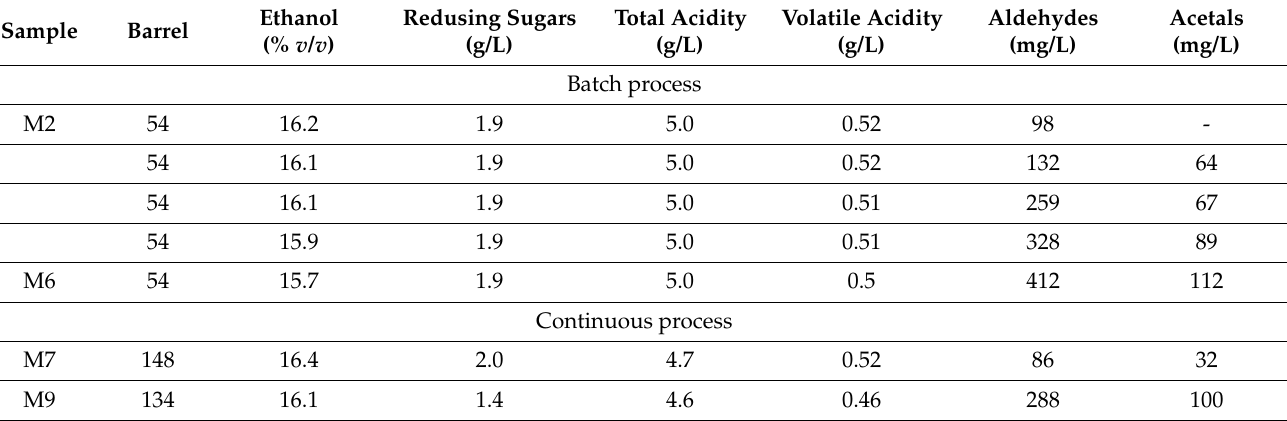
Table 1. Chemical composition of wine